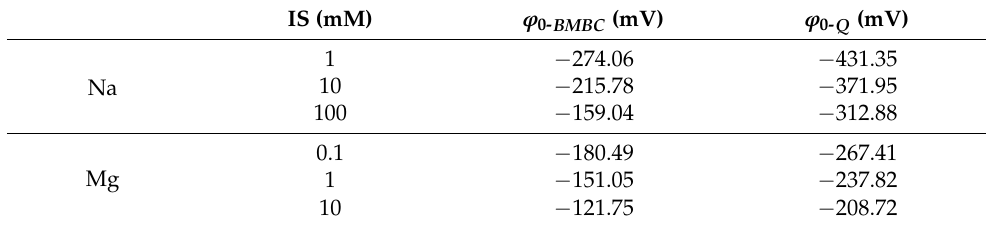
Table 1. Theoretical surface potential of BMBC and quartz sand.